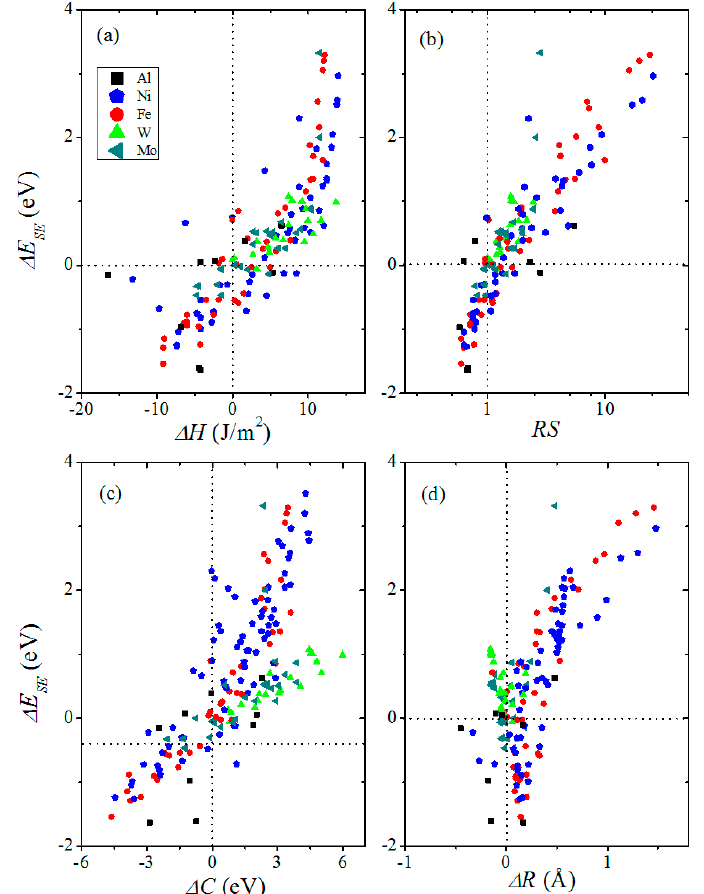
Figure 1. Trend of strengthening energies ∆ E SE plotted against ( a ) difference of sublimation enthalpies ∆ H , ( b ) ratio of the surface energies RS, ( c ) difference of cohesive energies ∆ C , and ( d ) difference of atomic radii ∆ R between the host and the segregated solute atoms. Data are from the aggregated data